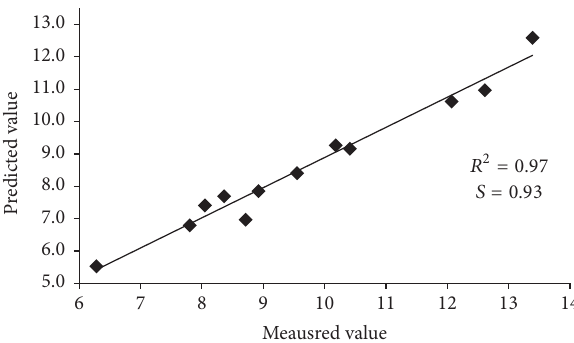
Figure 2: The linear correlation between the actual and the model- predicted protein level values in 12 flours samples of different